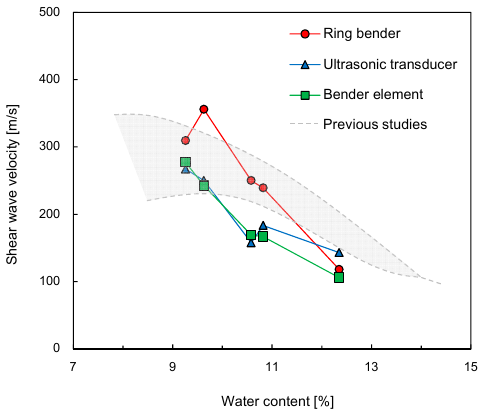
Figure 11. Relationship between water content and shear wave velocity.